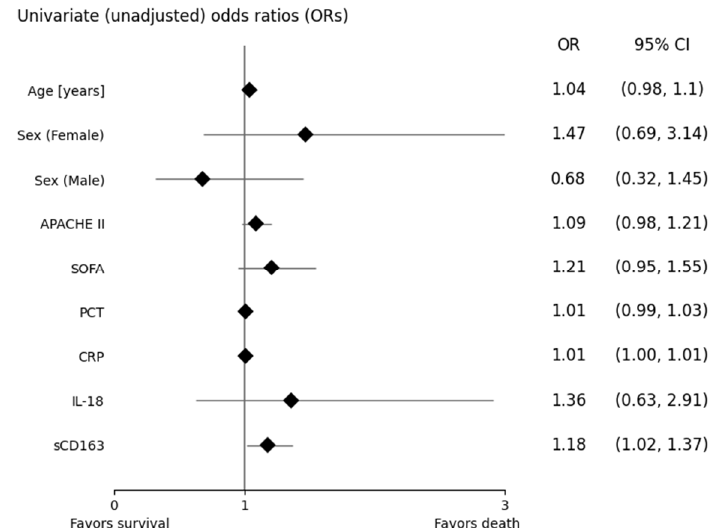
Figure 1. Forest plot of odds ratios (ORs) describing the odds of death among septic patients. ORs for IL-18 and sCD163 are given for log-transformed (base: 1.1.) values. APACHE II, acute physiology and chronic health evaluation II; SOFA, sequential organ failure assessment; PCT, procalcitonin; CRP, C ‐ reactive protein; IL ‐ 18, interleukin 18; sCD163, soluble CD163.